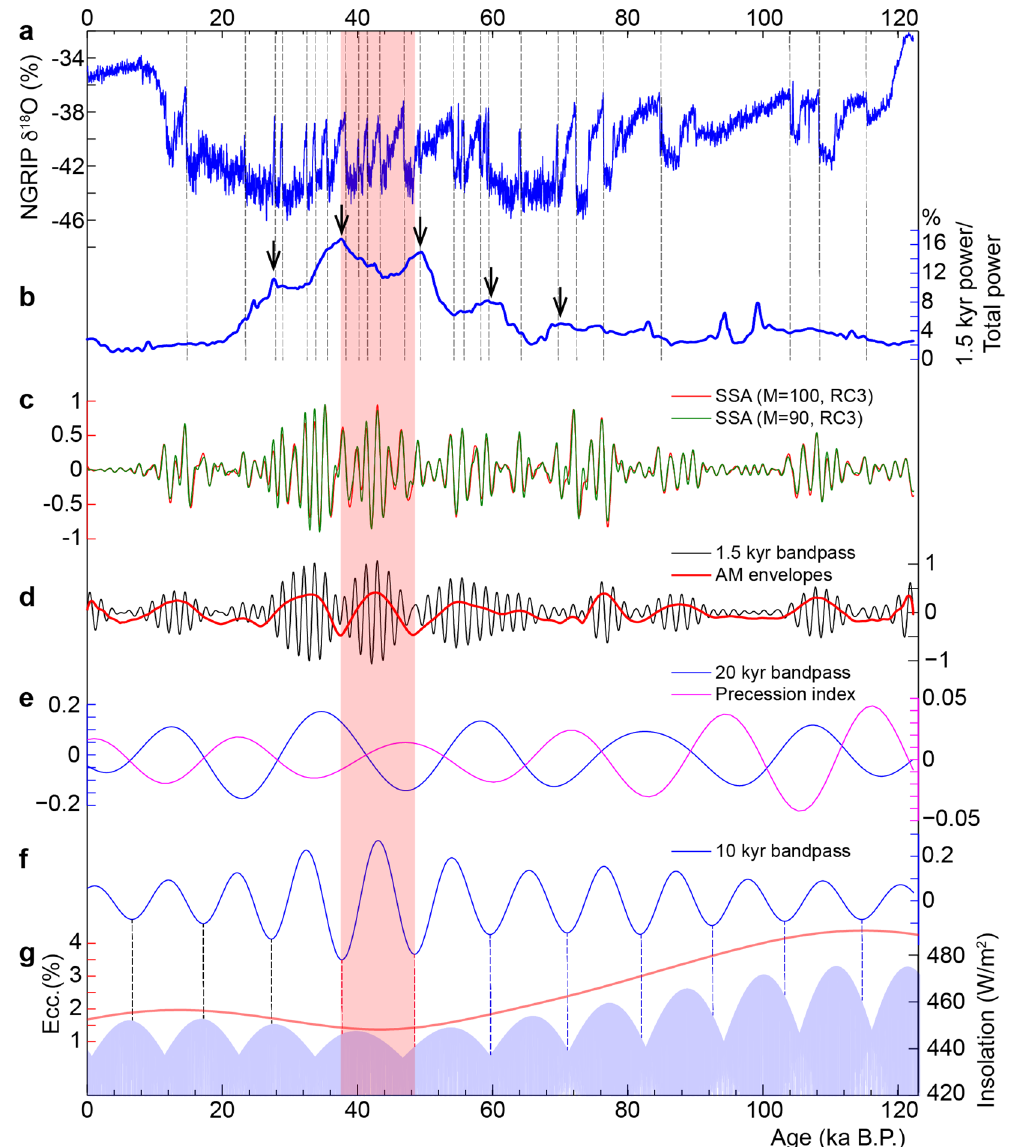
Figure 8. Amplitude modulation (AM) analysis of NGRIP climate proxy data at the 1.5 kyr cycle band. (a) δ 18 O record from Greenland ice core obtained from NGRIP at a regular sampling rate of 20 years (see “Methods”). Dansgaard-Oeschger (DO) Events are indicated by vertical dashed lines. (b) Evolutive power spectra of the 1.5 kyr cycle band (1.5 kyr power over the total δ 18 O power). Sliding window = 20 kyr, 1.5 kyr selected band = 0.6 ± 0.1 cycles/kyr, MTM time-bandwidth product = 2. Black arrows indicate the half-precession cycles modulating DO events. (c) SSA reconstructed components (RC) to isolate the 1.5 kyr cycle band. (d) Bandpass flitered δ 18 O data at the 1.5 kyr cycle band (0.6 ± 0.1 cycles/kyr) and Hilbert transform output (AM envelopes). (e) 20 kyr bandpass filered (0.043 ± 0.015 cycles/kyr) AM envelopes along with the precession index. (f) 10 kyr bandpass filered (0.095 ± 0.02 cycles/kyr) AM envelopes. (g) The equatorial insolation modelled with a sampling step of one month (see “Methods”). The light blue-shaded area depicts the annual cycle, which is modulated by the first precession harmonic (half-precession), the precession and the eccentricity cycles (lower insolation values are truncated at almost the mean value of 420 W/m 2 ) (the complete data over a longer time interval of 500 ka is shown in Supplementary Fig. S12). The red curve depicts Earth’s orbital eccentricity. Orange-shaded area depicts the change in phase correlation at half-precession band, between astronomical and paleoclimatic